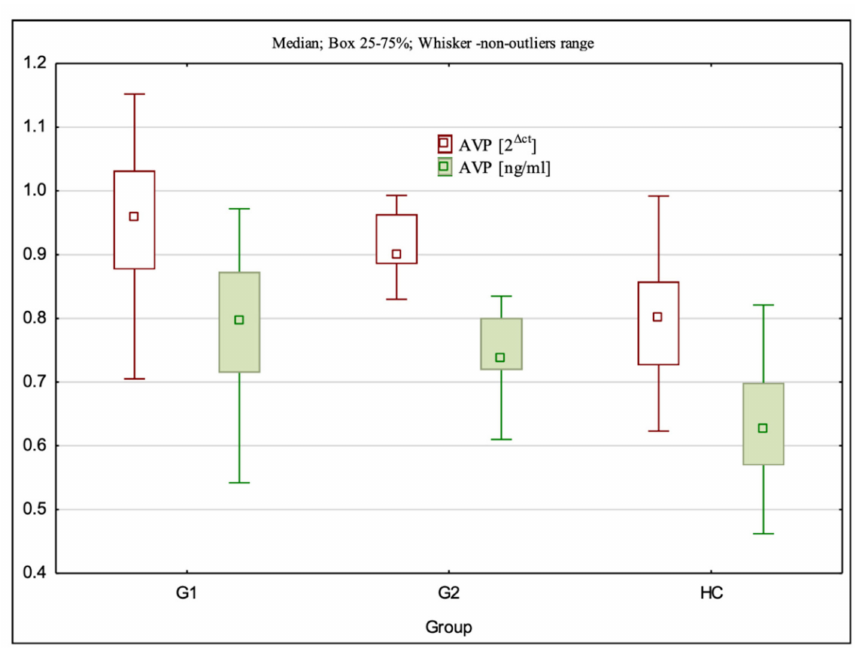
Figure 3. AVP gene expression at the mRNA and protein levels in the studied population.